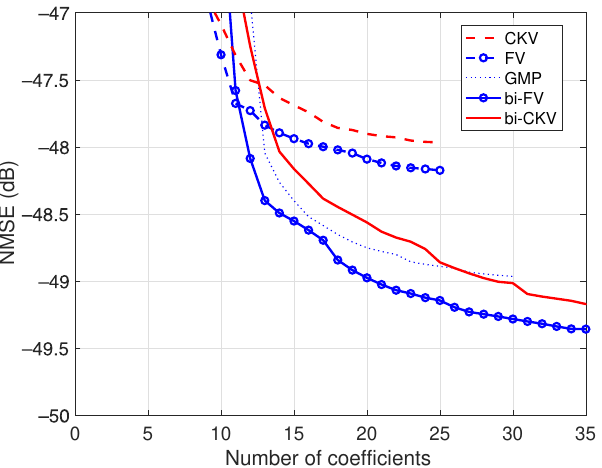
Figure 4. NMSE results of the conventional and the bivariate Volterra models, for a class AB power amplifier operated at 3.6 GHz with an average output power of 27.4 dBm.